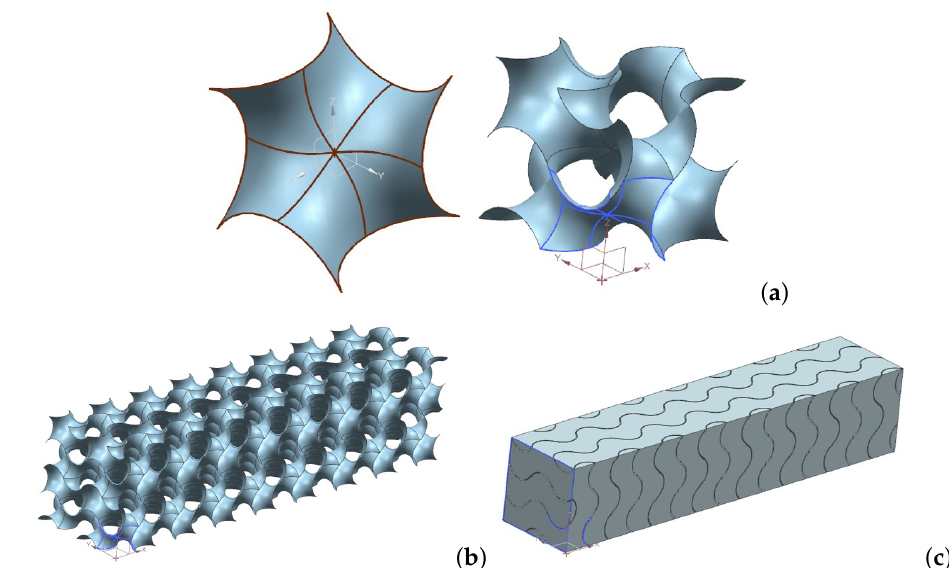
Figure 3. Creation of the gyroid from the unit surface ( a ) to the metal foam structure ( b ) and the fluid volume ( c ).